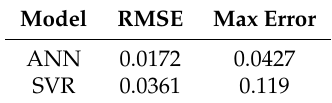
Table 9. Accuracy metrics of ANN and SVR